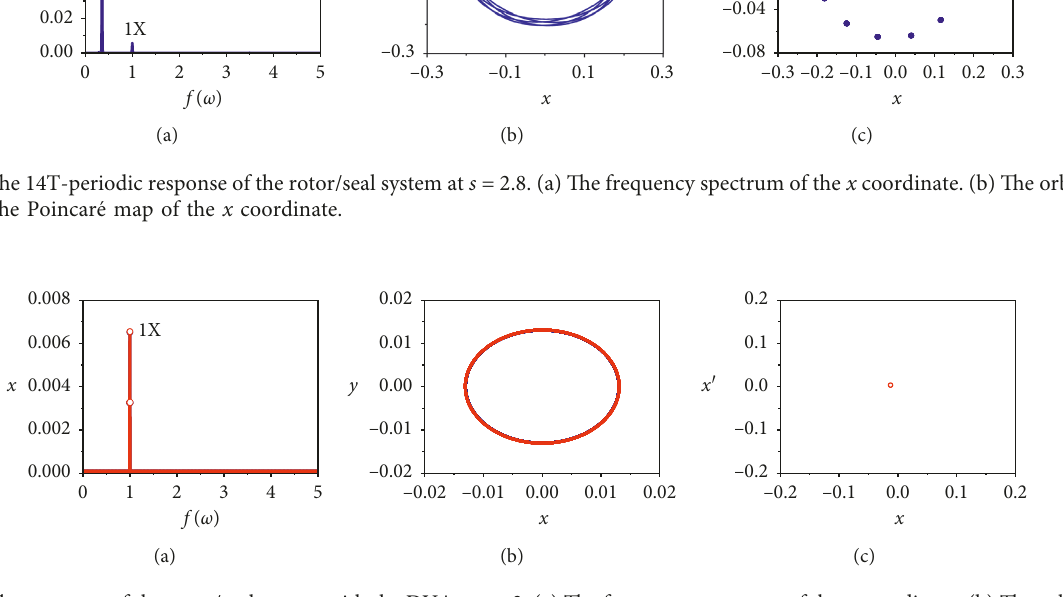
2. (a) The frequency spectrum of the x coordinate. (b) The orbit of the (cid:31)